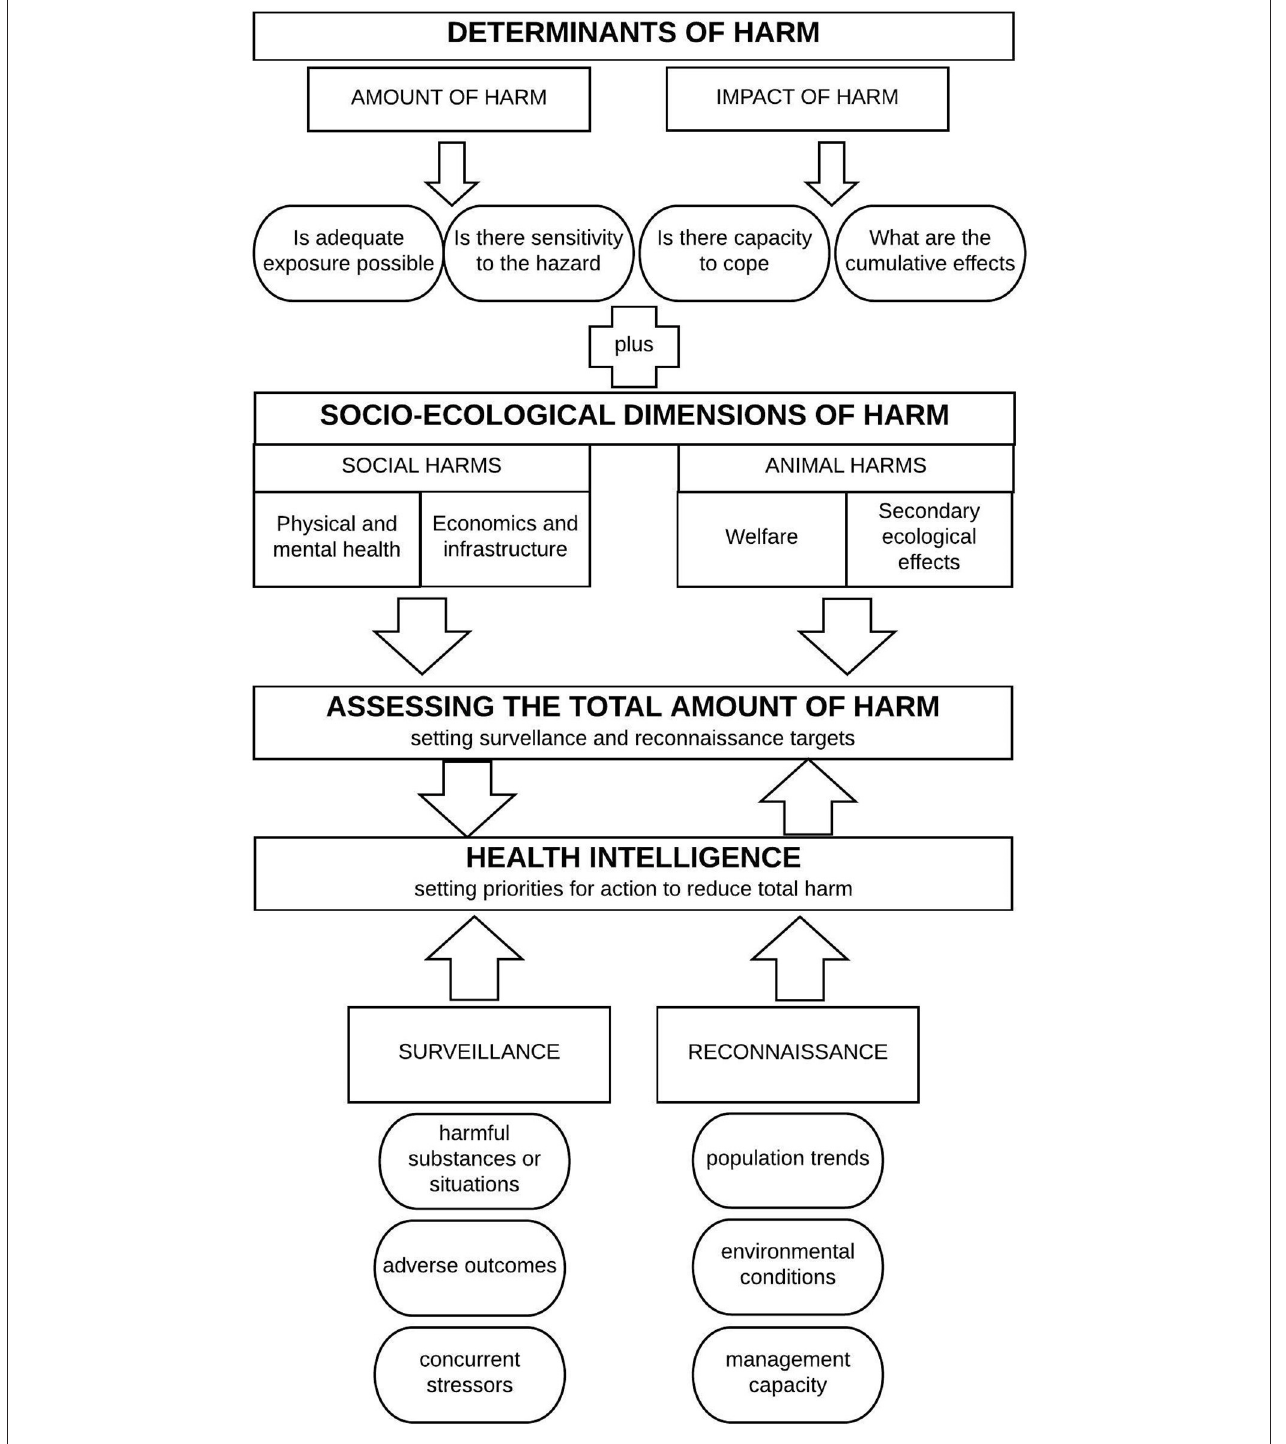
FIGURE 1 | Conceptual model of the integration of health intelligence and harm reduction to set priorities for urban wildlife health surveillance and action.